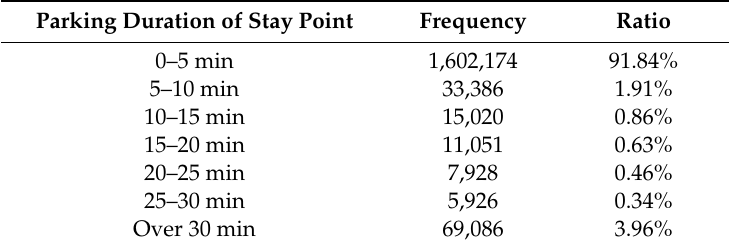
Table 5. Frequency distribution table of car sharing orders’ stay